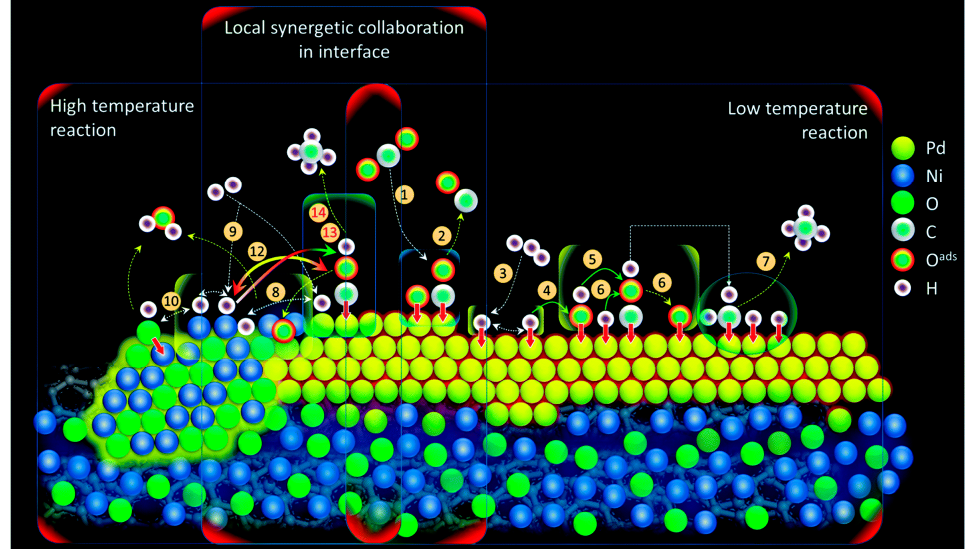
Figure 15. Schematic representation of the reaction coordinates in the NiO T Pd-T. Reproduced with permission from [125].